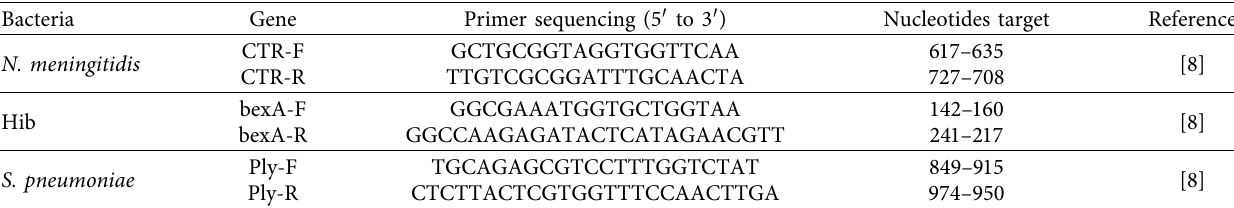
Table 1: Primer sequencing in multiplex real-time